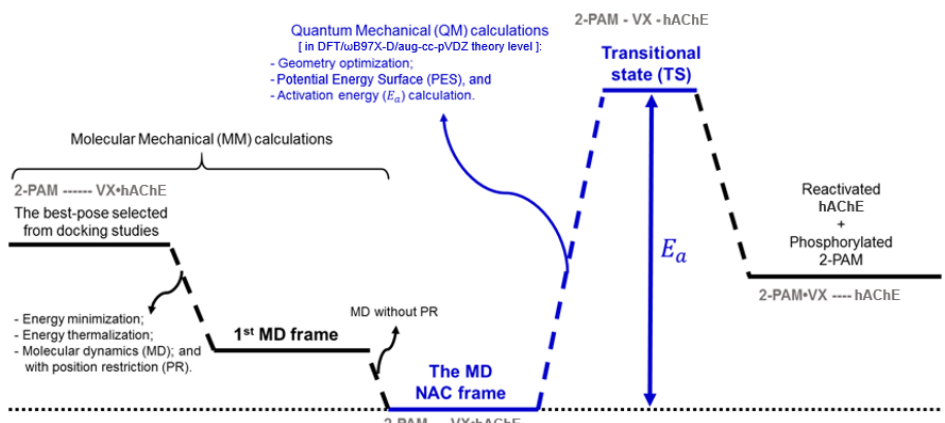
Figure 2. Energy profile obtained through the quantum mechanics (QM)/molecular mechanics (MM) methodology.